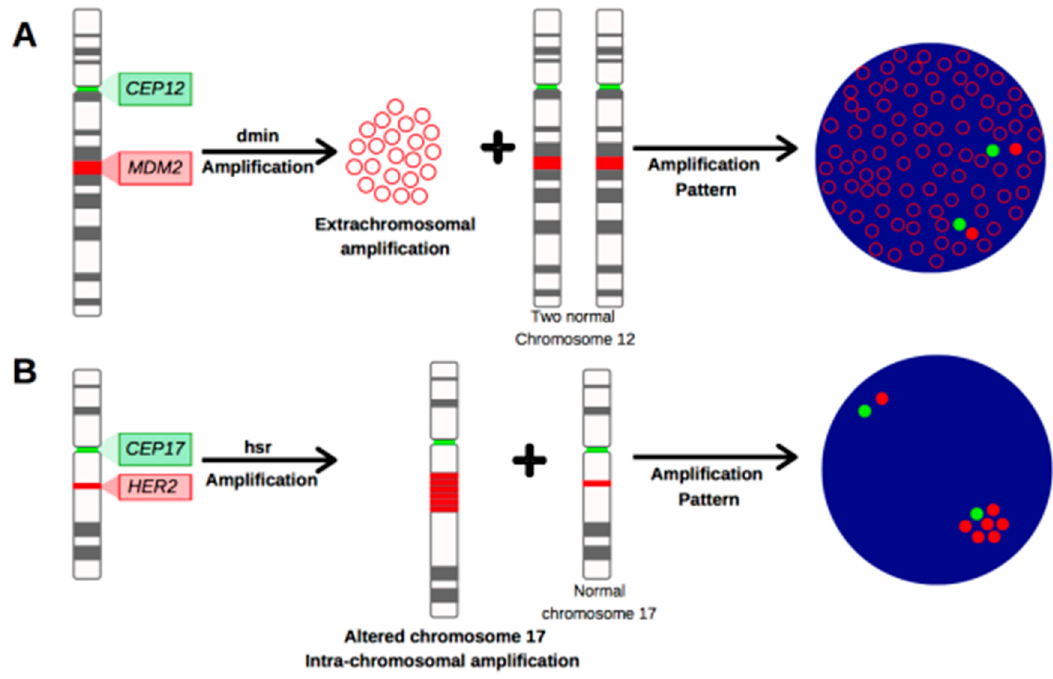
Figure 5. Gene amplification patterns. Amplified DNA can be observed in two different patterns: ( A ) Gene amplification in extra chromosomal entities called double minutes (Dmins). Small fragments of extra chromosomal DNA scattered over the whole nucleus are commonly observed. This pattern is characteristic of the MDM2 gene. ( B ) Gene amplification in intrachromosomal entities called homogeneously staining regions (HSR). HSR are chromosomal segments of various lengths but uniform staining intensity. In the chromosomal region where HSR occur, a segment of the chromosome is amplified or duplicated several times. This pattern is the most common in HER2 amplified cases.